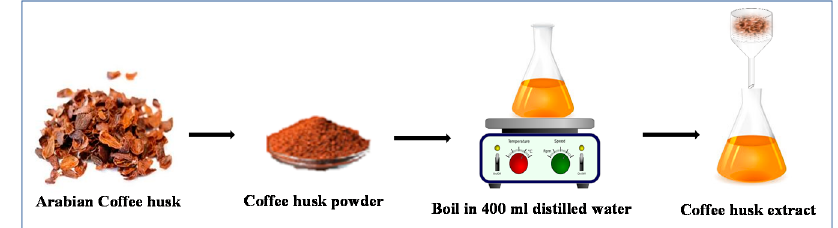
Figure 10. Schematic representation of preparation of coffee husk extract (CHE).